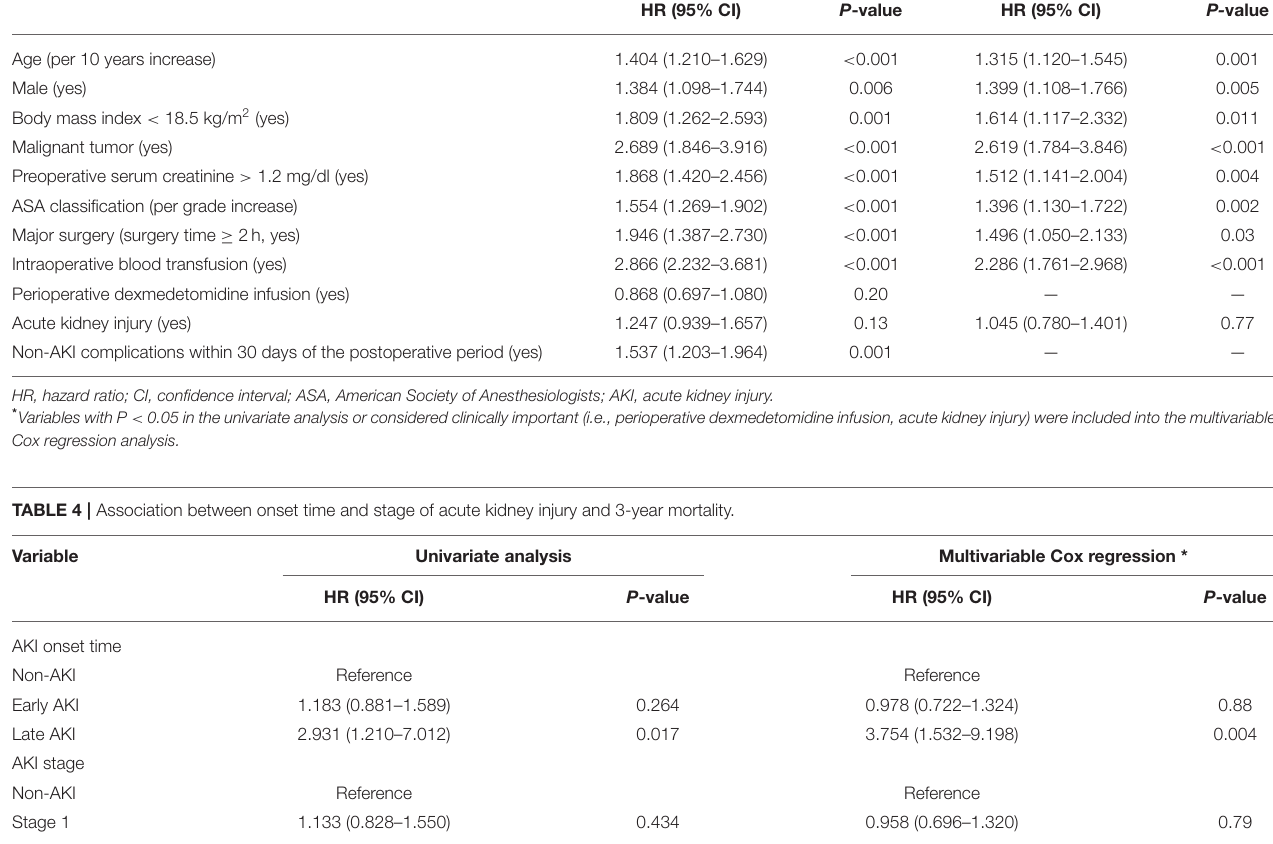
TABLE 3 | Association between acute kidney injury and 3-year mortality. Variables